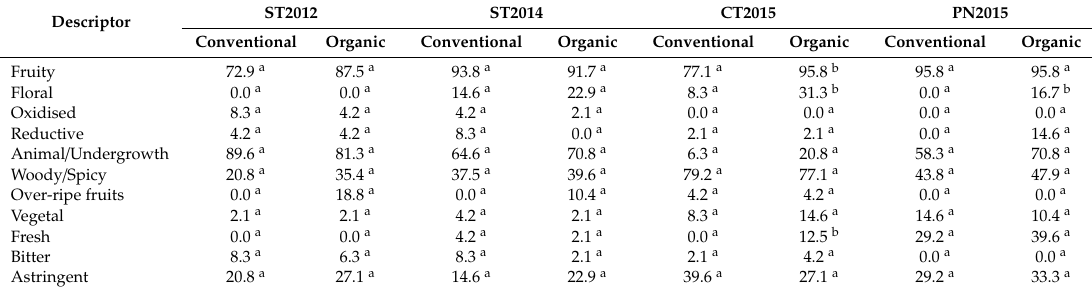
Table 8. Frequency of citations of each sensory descriptor elicited by red wines during “Conventional” and “Organic” tasting sessions